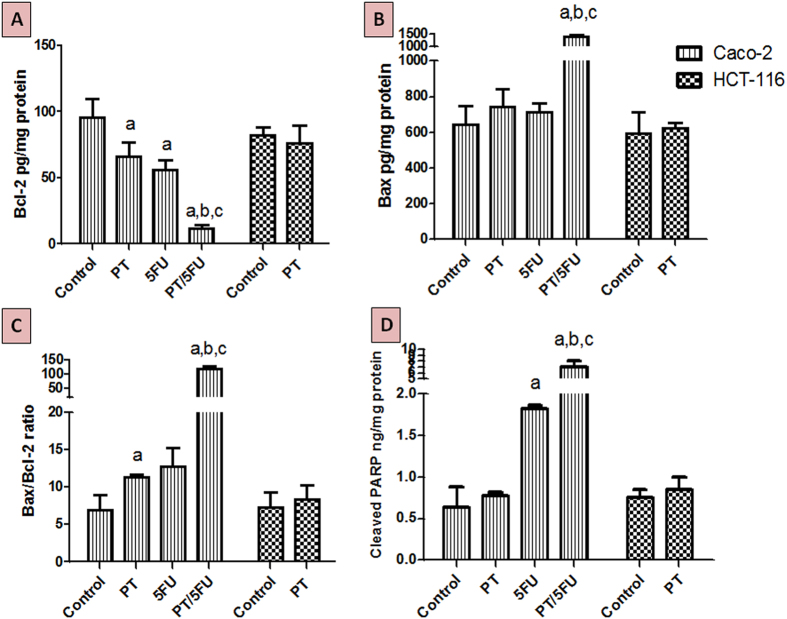
Effect of PT on the protein levels of (A) Bax, (B) Bcl-2, (C) Bax/Bcl-2 ratio and (D) PARP in Caco-2 and HCT-116 colon cancer cell lines using ELISA assay. Data are means ± SD (n = 3). The experiment was done in triplicates. a indicates significant difference from Caco-2 control at p < 0.05. b indicates significant difference from Caco-2/PT group at p < 0.05. c indicates significant difference from Caco-2/5-FU group at p < 0.05.